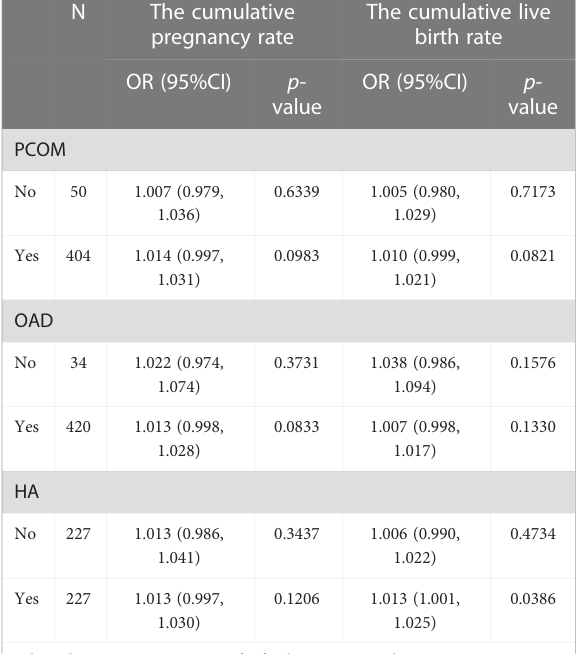
TABLE 7 Strati fi cation analysis of follicular output rate and cumulative clinical outcomes.